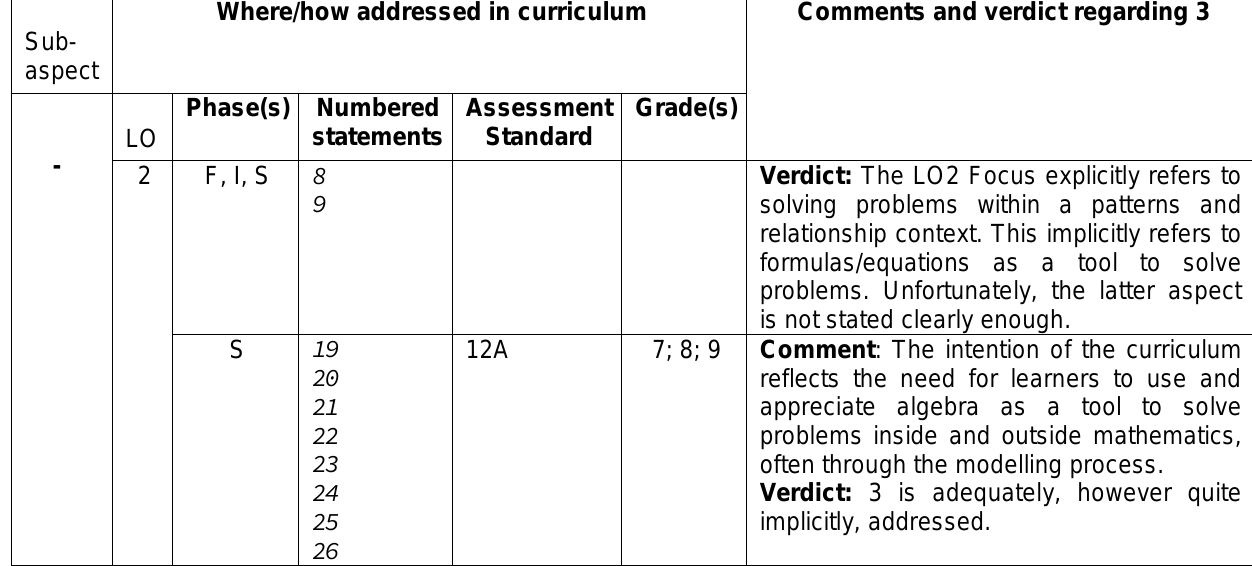
Table 12. Aspect 3: enable learners to use and appreciate algebra as a tool to solve problems inside and outside mathematics